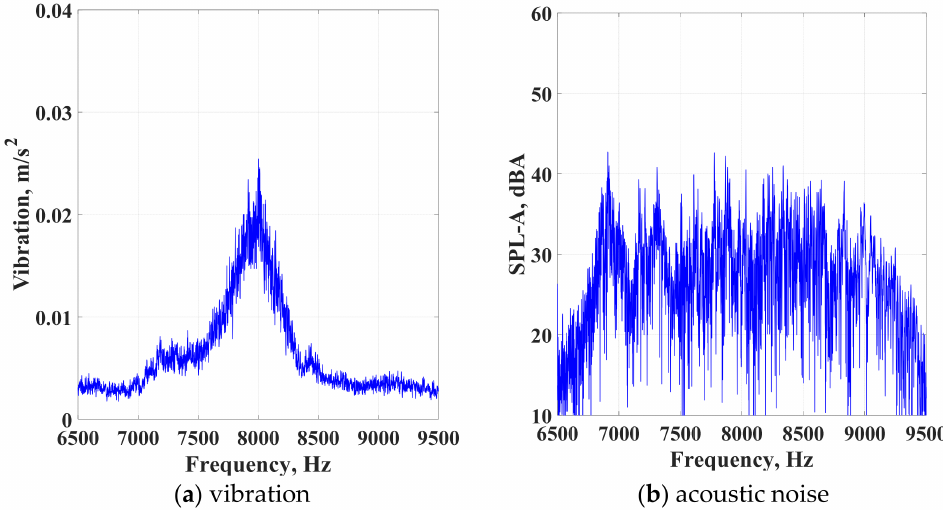
Figure 12. The sideband vibro-acoustic responses with the HCFM. Table 2. Sideband current harmonics and vibro-acoustics with the proposed PWM schemes.